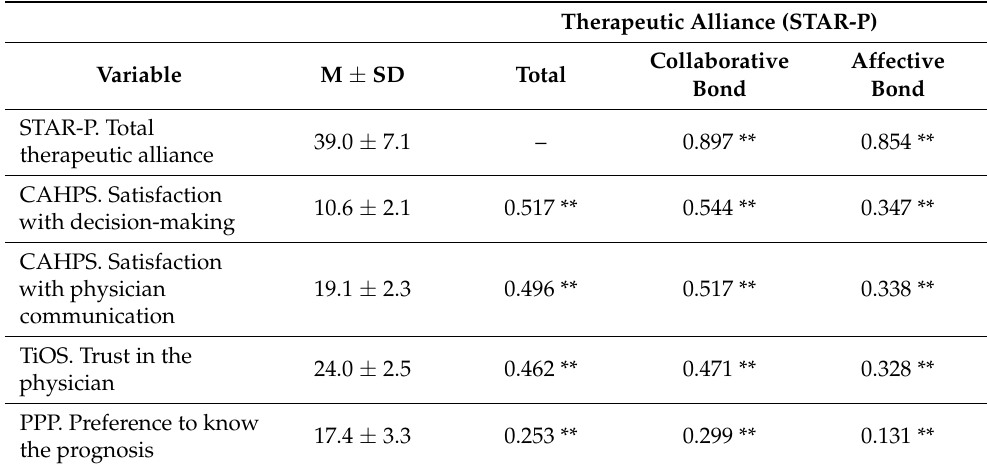
Table 2. Correlations between therapeutic alliance and psychological variables ( n =